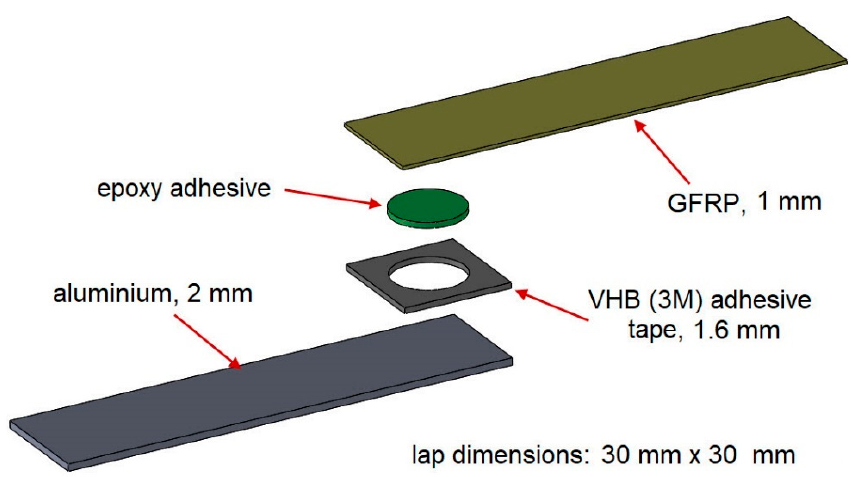
Figure 1. Structure of the dual-adhesive sample for the first stage of the study.